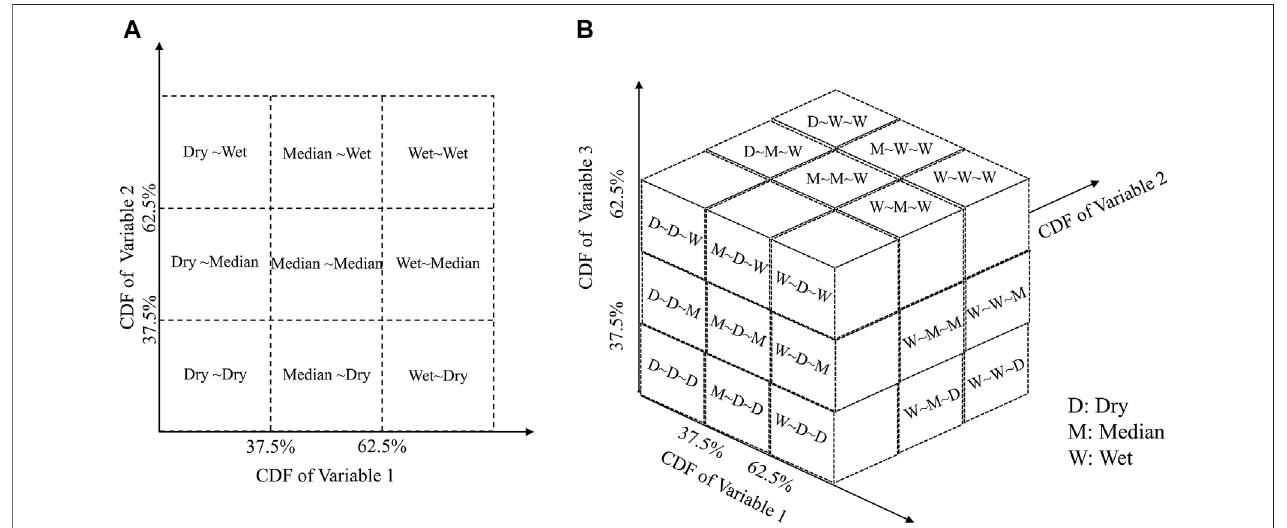
FIGURE 1 | Sketch of the dryness – wetness encounter probabilities: (A) bivariate joint probability and (B) trivariate joint probability.